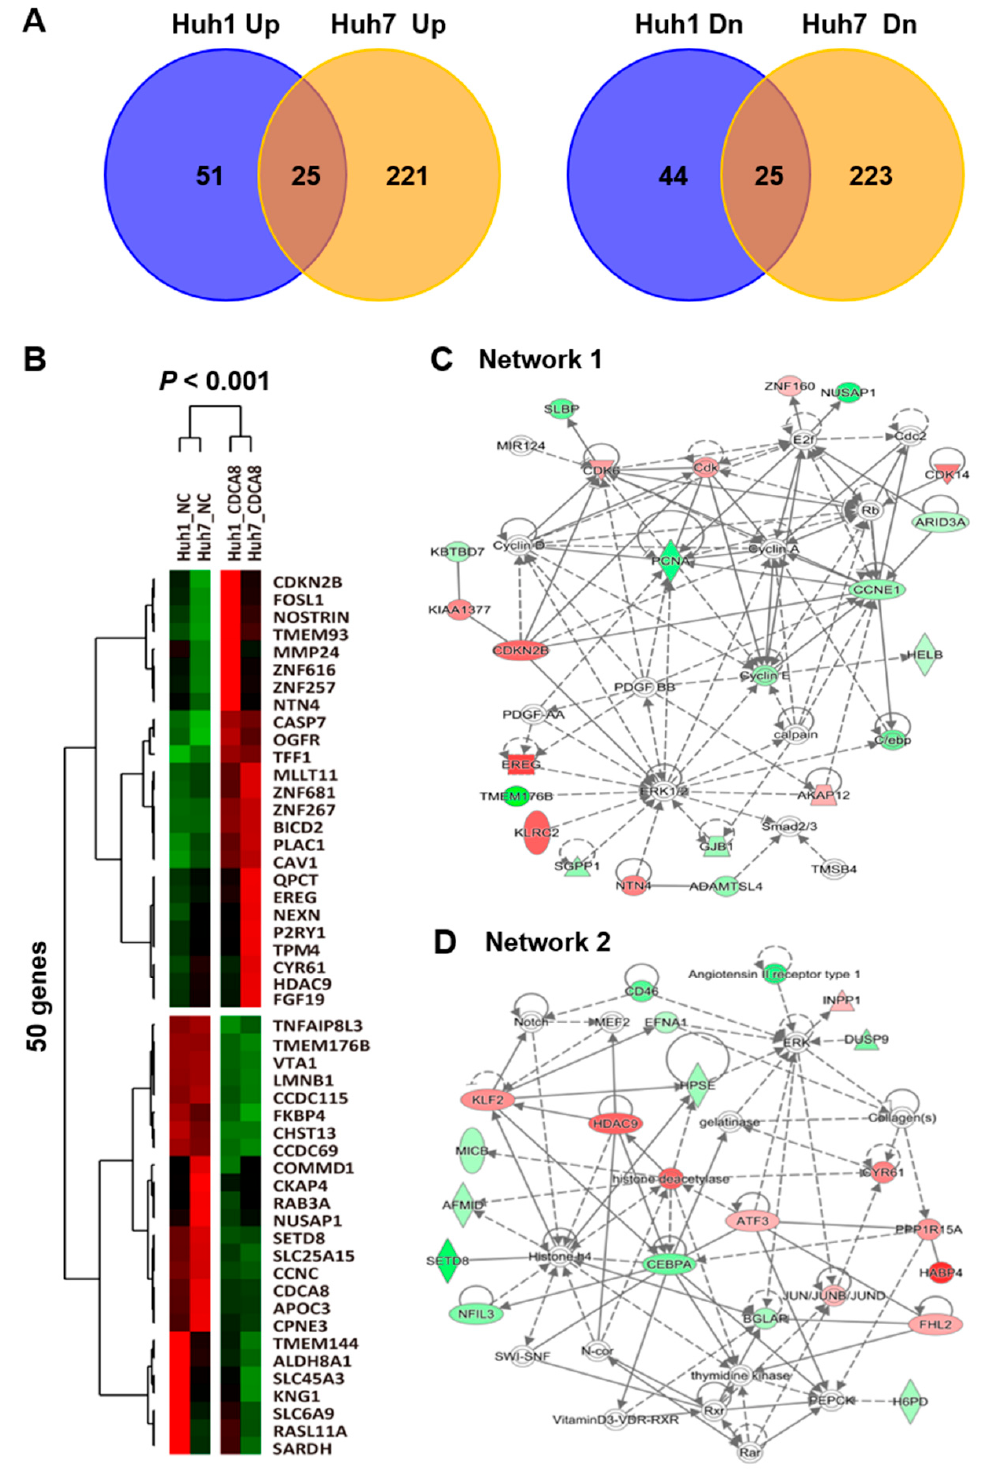
Figure 5. Global observation of dysregulated genes in HCC cells with CDCA8 depletion. ( A ) The number of genes dysregulated in Huh1 and/or Huh7 cells over 48 h of CDCA8-1siRNA treatment. ( B ) A heat map of the 50 commonly up- or downregulated genes in Huh1 and Huh7 cells. p < 0.001, red (upregulated) and green (downregulated). ( C , D ) Two putative ingenuity pathway analysis (IPA) top networks highly associated with PCNA ( C ) or ATF3 ( D ).